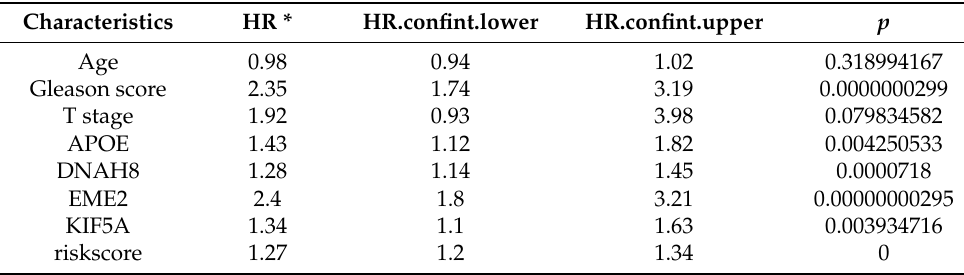
Table 4. Results of independent prognostic univariate and multivariate Cox